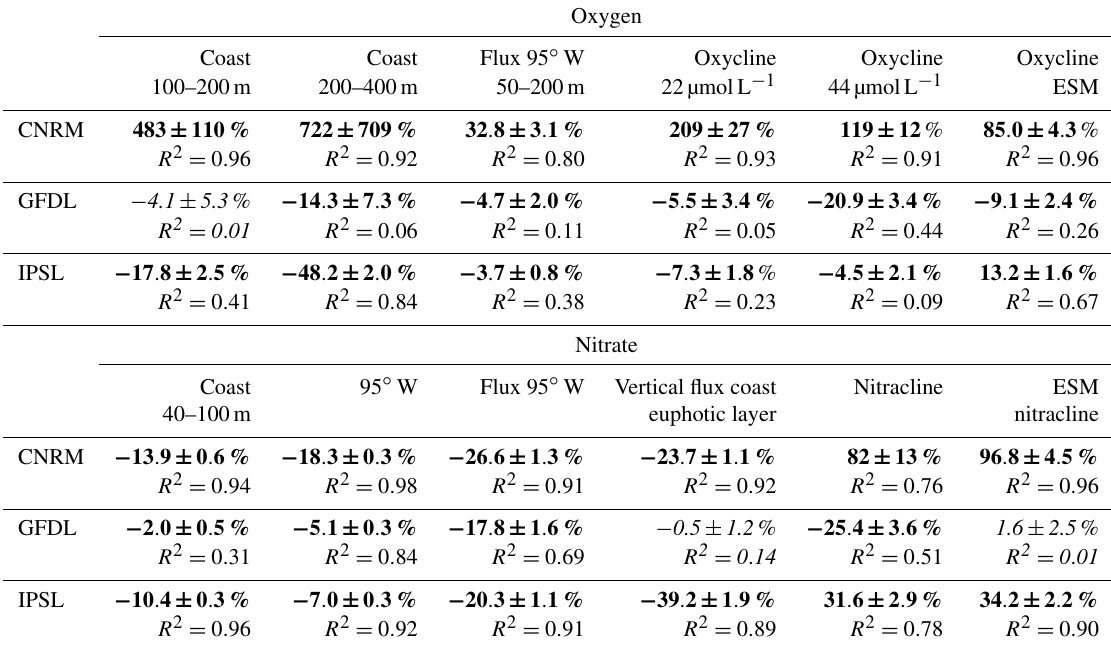
Table 4. Differences (in percent) between 2100 and 2006 (with respect to value in 2006) computed from RCM and ESM linear trends and R 2 for nearshore oxygen content, eastward oxygen flux, oxycline depth for RCM and ESM, nitrate content nearshore and at 95 ◦ W, eastward nitrate flux, upward nitrate flux into the euphotic layer, and nitracline depth for RCM and ESM. Bold font indicates significant values with a 90% level of confidence. Italic font indicates values below the 90% level of confidence.